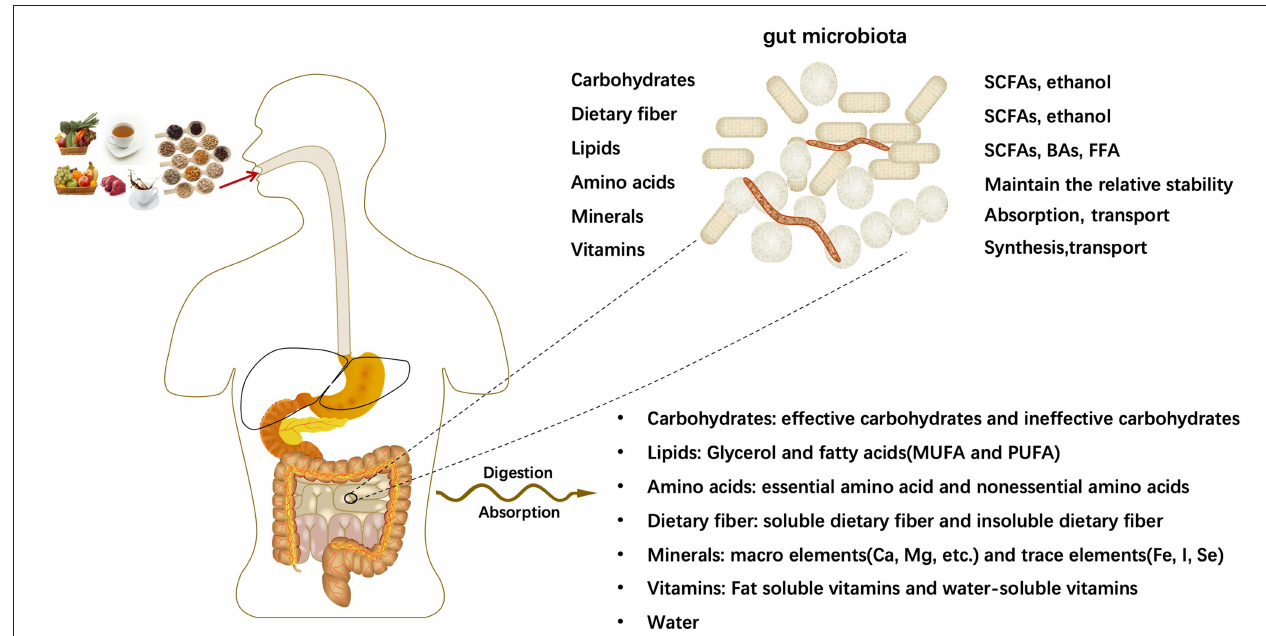
FIGURE 1 | Digestion and absorption of